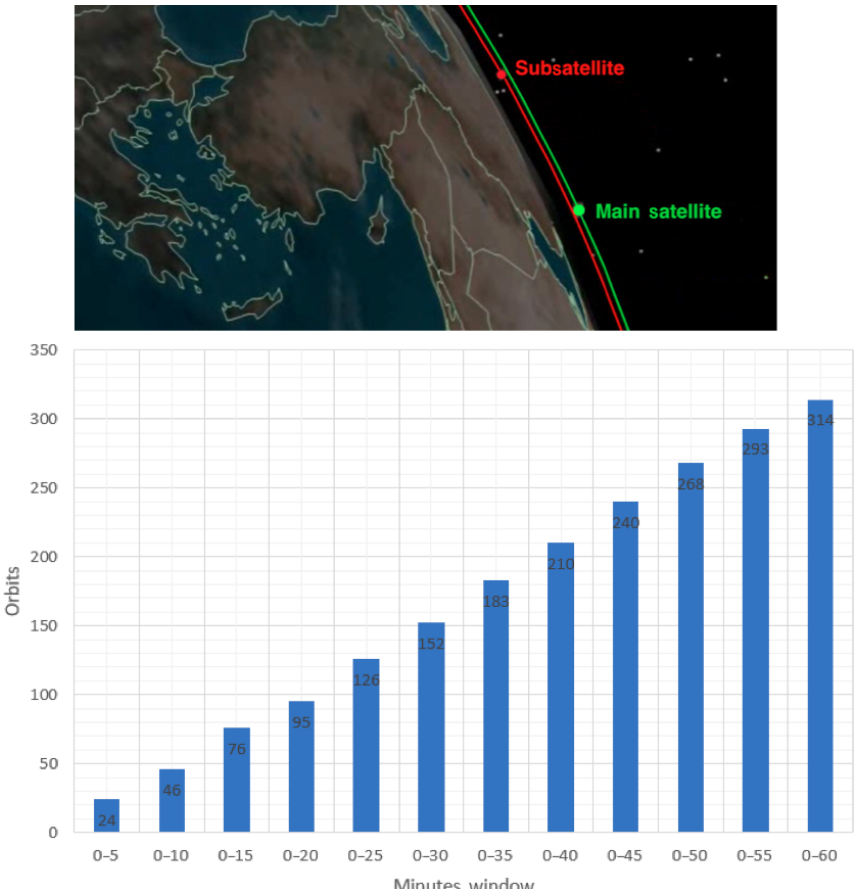
Figure 18. Temporal offsets between the main satellite and a released subsatellite are binned in time windows with 5min increments, and the cumulative number of orbits within each window is plotted as a function of the temporal